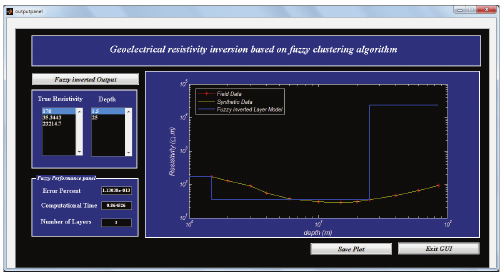
Figure 9: Output panel showing the fuzzy subtractive clustering inverted model for data 2.